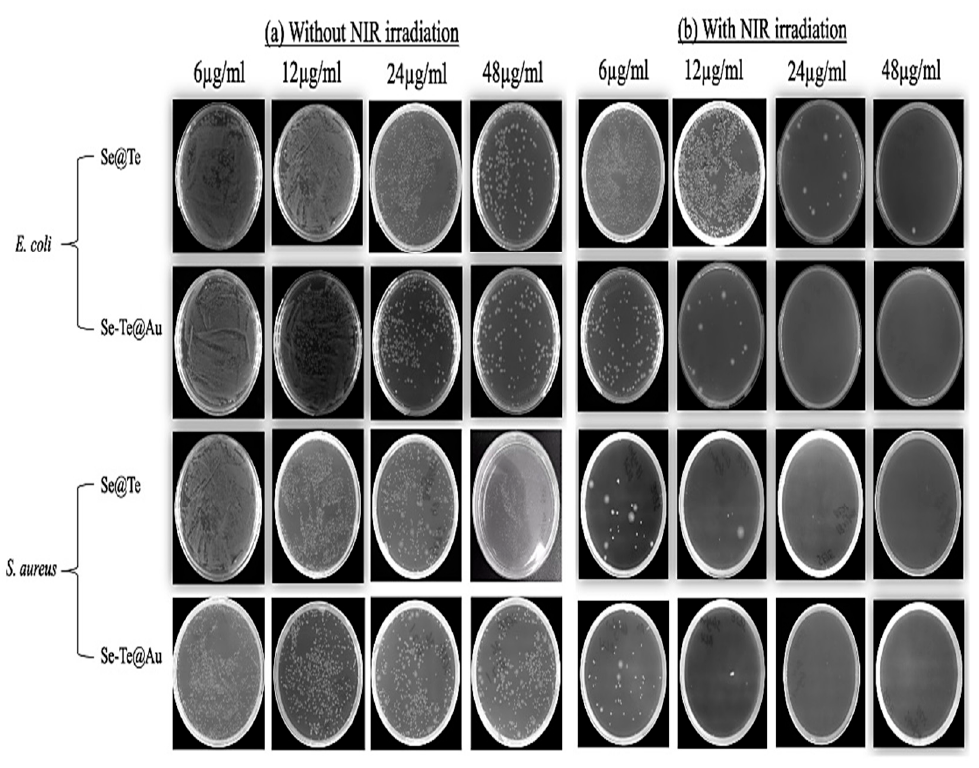
Figure 4. Antibacterial activity ( a ) shows the activity of Se-Te and Se-Te@Au treated without NIR against E. coli and S. aureus with different concentration. ( b ) Represents the activity of Se-Te and Se-Te@Au with NIR in different concentrations.